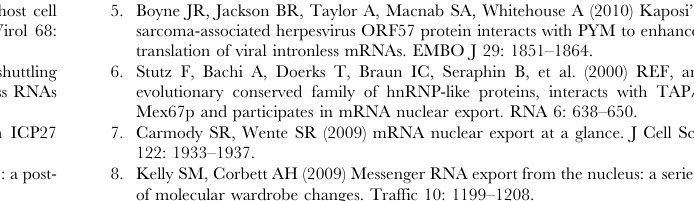
(green), bound to ORF57 8–120 (blue) suggests that the binding of ICP27 and ORF57 fragments affects essentially the same signals and hence occurs at the same binding site. All NMR experi- Figure S4 Analysis of ICP27 103–138 interactions with REF 54–155 using NMR spectroscopy. (A) Amino acid sequence of ICP27 construct. The sequence from the remaining PreScission protease cleavage site is coloured blue. (B) Chemical shift changes in backbone amides of ICP27 103–138 upon addition of Ref 54–155 , red squares. The horizontal dashed lines represent thresholds for strong and medium shift changes used for creating the summary Fig. 2. (C) Heteronuclear 15 N [ 1 H] NOEs measured for ICP27 103–138 in free form (green circles) and in presence of REF 54–155 (red squares) were used to detect the change in polypeptide mobility. (D) Overlay of 1 H- 15 N-correlation HSQC spectra of wild type ICP27 103–138 (blue) with ICP27 103–138 S114E (red) in free form and ICP27 103–138 S114E with a 5-fold excess of REF 54–155 added (green). The inset at the top right shows indole region of the spectrum. (E) Overlay of 1 H- 15 N- correlation HSQC spectra of ICP27 103–138 with various amounts of added REF 54–155 . Labels show sequence-specific signal assignment. Spectra are coloured blue (through green) to red for the free and complexed peptide respectively. For clarity only the 1:0, 1:0.25, 1:0.5, 1:0.75, 1:2, and 1:6 (ICP27:REF) spectra are shown. (F) Comparison of 15 N-HSQC spectra of ICP27 103–138 peptide in free (blue) and REF 54–155 bound form (red) and ICP27 1–138 in free (cyan) and REF 54–155 bound form (orange). Assignments for bound form of ICP27 103–138 are shown. The spectrum of ICP27 103–138 overlays well with the spectrum of ICP27 1–138 , this suggests that the truncation does not disrupt the structure of the shorter construct. The REF-binding site of ICP27 1–138 is all situated within the 103– 138 fragment, as signals from other parts of this longer viral protein construct are not affected by binding with REF. Figure S5 Analysis of ORF57 8–120 interactions with REF 54–155 using NMR spectroscopy. (A) Amino acid sequence of ORF57 construct, with T7 and poly-His tags coloured blue. (B) Chemical shift changes in backbone amides of ORF57 8–120 upon addition of REF 54–155 are shown as red triangles. The arrows identify residues broadened beyond detection in the bound state. The horizontal dashed lines represent thresholds for strong and medium shift changes used for creating the summary Fig. 2. (C) 15 N [ 1 H] NOEs measured for ORF57 8–120 in free form (black crosses) and in presence of REF 54–155 (red squares) identify regions with polypeptide mobility changed upon binding. Orange stars mark residues with amide signals broadened beyond detection in the complex, for these no NOE data could be obtained. (D) Overlay of 15 N-HSQC spectra for titration of ORF57 8–120 with REF 54–155 . Spectral assignment is shown. Spectra are coloured orange though